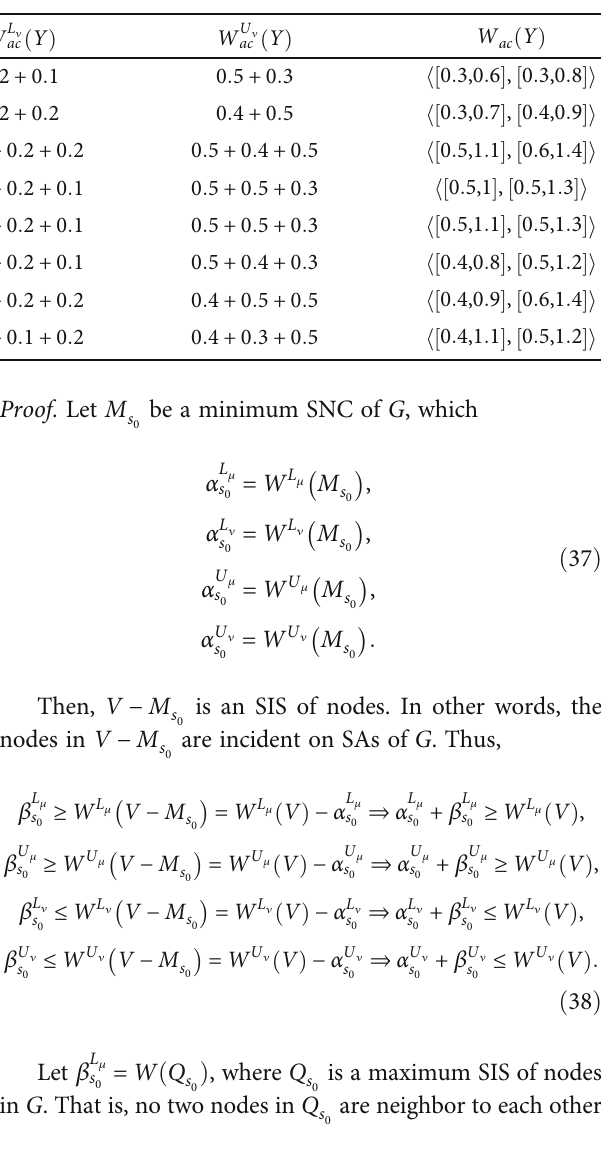
Figure 3: A strong IVIFG G for strong maching (SM). Table 4: Calculating the weight of strong arc cover sets Y